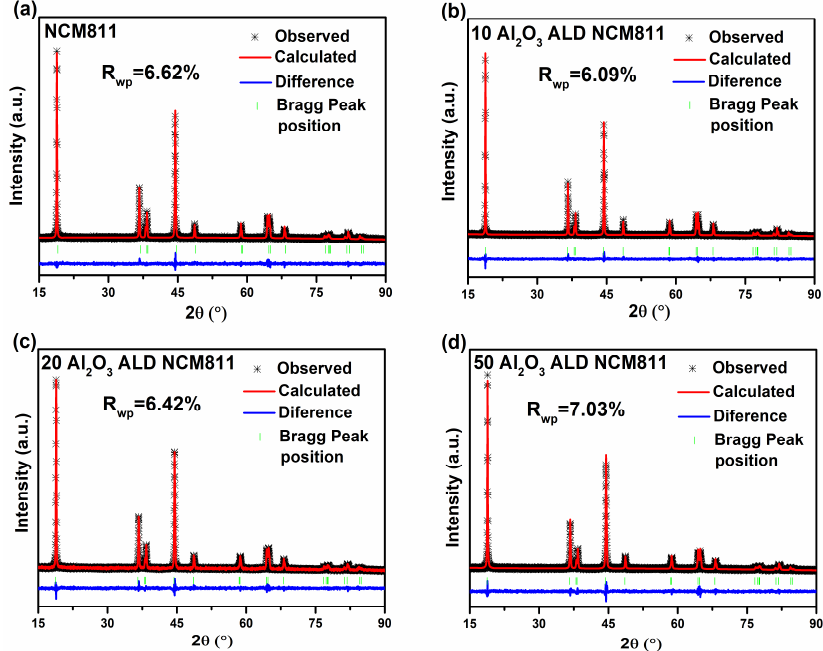
Figure 2. XRD patterns of ( a ) bare NCM8111; ( b ) 10 Al 2 O 3 ALD NCM8111; ( c ) 20 Al 2 O 3 ALD NCM8111; and ( d ) 50 Al 2 O 3 ALD NCM8111 materials, coupled with rietveld refinement